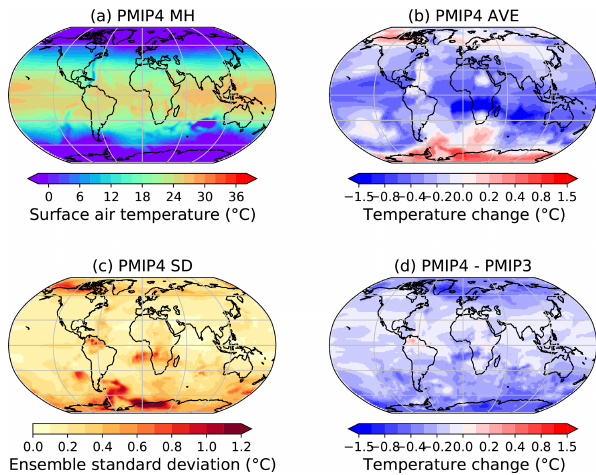
Figure 4. Annual mean surface temperature in the midHolocene simulations ( ◦ C). (a) The multi-model mean, Mid-Holocene an- nual mean surface temperature simulated by PMIP4-CMIP6 mid- Holocene simulations. (b) The multi-model mean, annual mean temperature changes in PMIP4-CMIP6 (midHolocene − piControl) and (c) the inter-model spread, defined as the across-ensemble stan- dard deviation. (d) The difference in the multi-model mean, annual mean temperature changes between PMIP4-CMIP6 and PMIP3- CMIP5. Panels (a) , (b) and (c) are replotted from panels (a), (b) and (e) respectively in Fig. 1 of Brierley et al.